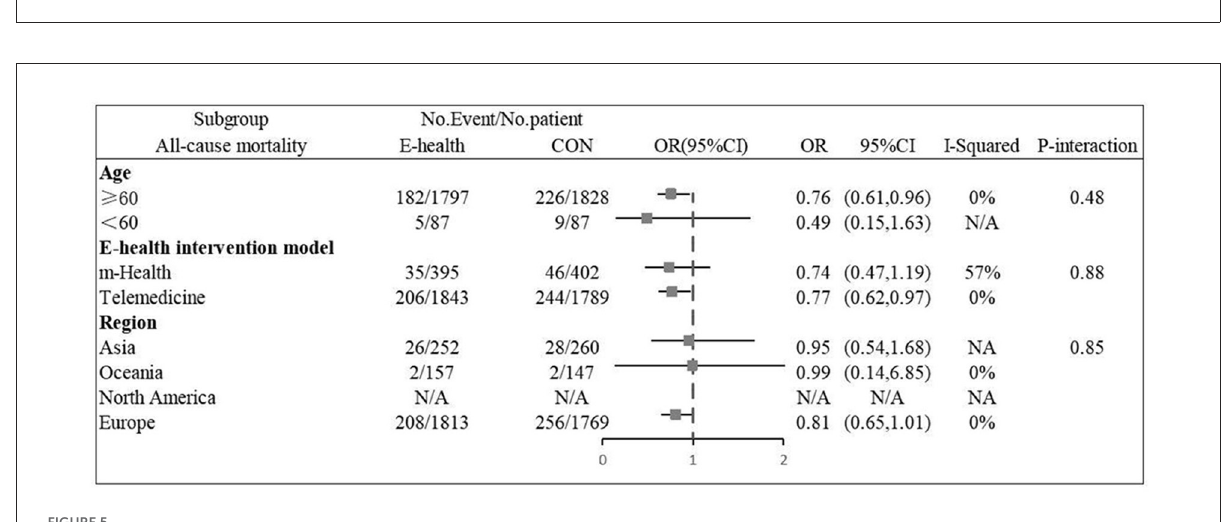
FIGURE5 Subgroup analysis for outcome of all-cause